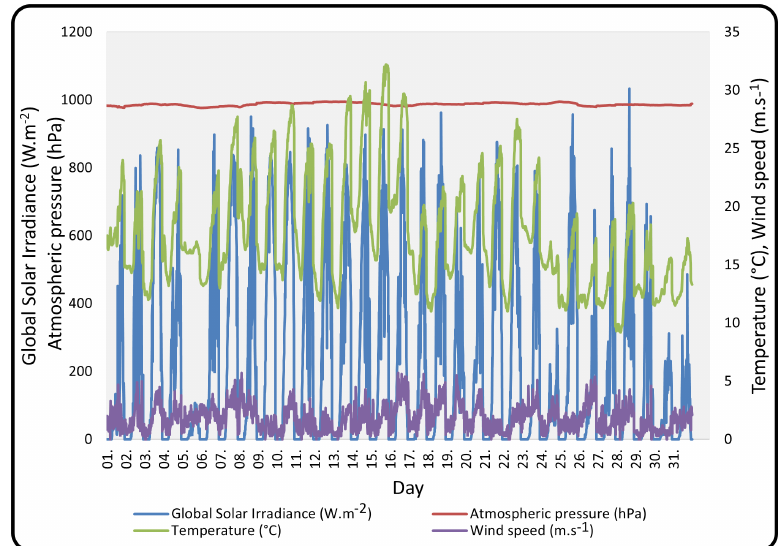
Figure 5. Variations in weather conditions in August 2021.